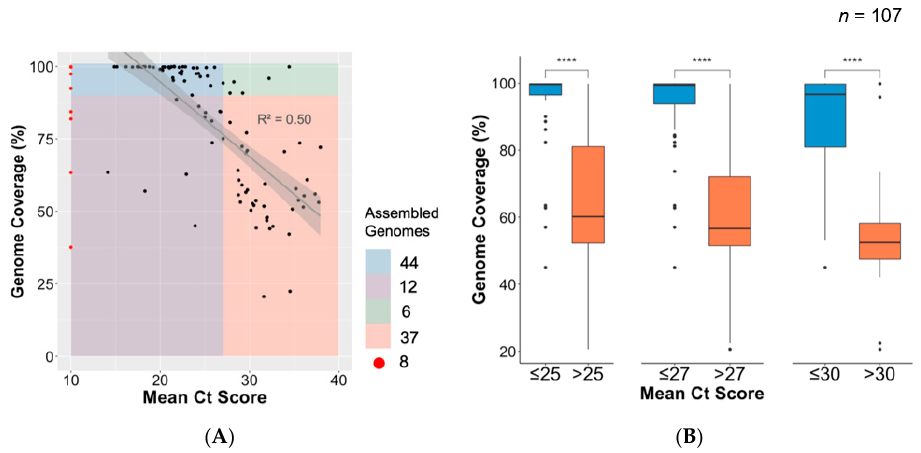
Figure 3. Association between cycle threshold (Ct) value and genome length. ( A ) Regression plot of mean Ct value of all unique samples against their genome lengths (% coverage against SARS-CoV-2 reference). Samples with missing Ct value information ( n = 8) are shown in red. Forty-four assembled genomes of >90% were produced from samples having Ct value <27 (blue); six genomes of >90% and